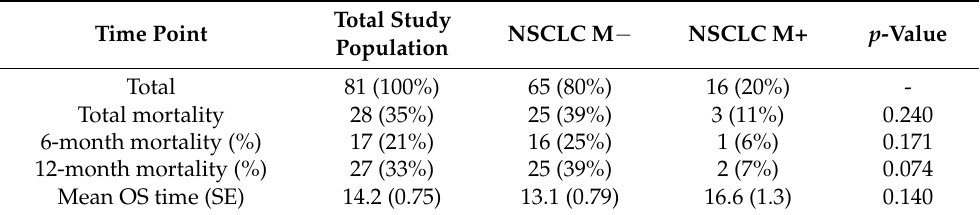
Table 4. Mortality